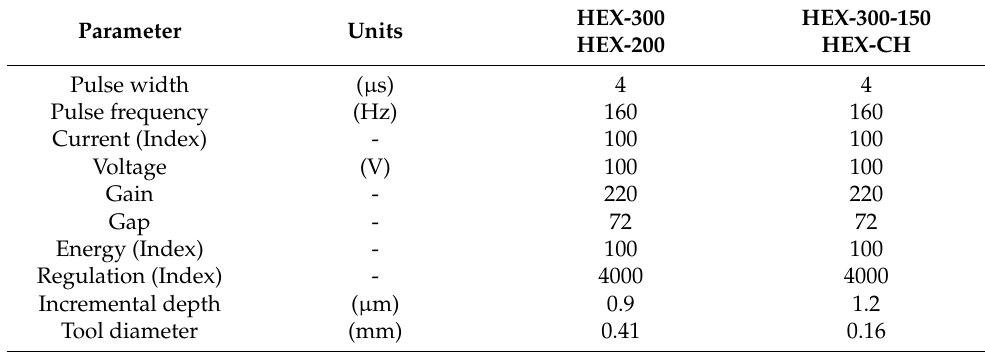
Table 3. Micro-EDM process parameters.